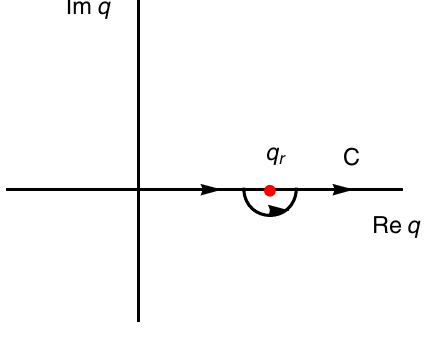
FIG. 16. Integration path C in the complex plane of variable q